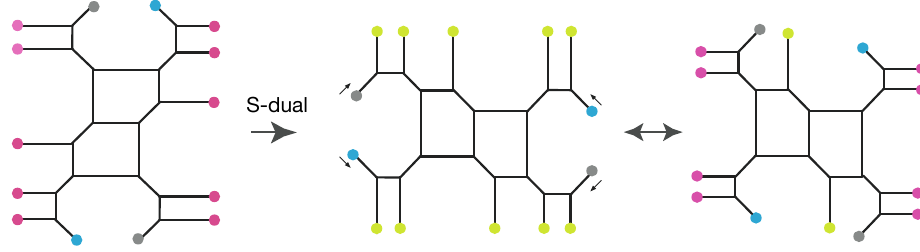
Figure 5 . The S-dual of SU(3) theory with N f = 10 (cid:13)avor is SU(2) (cid:2) SU(2) quiver theory with N f = 4 (cid:13)avors to each SU(2) theory of the